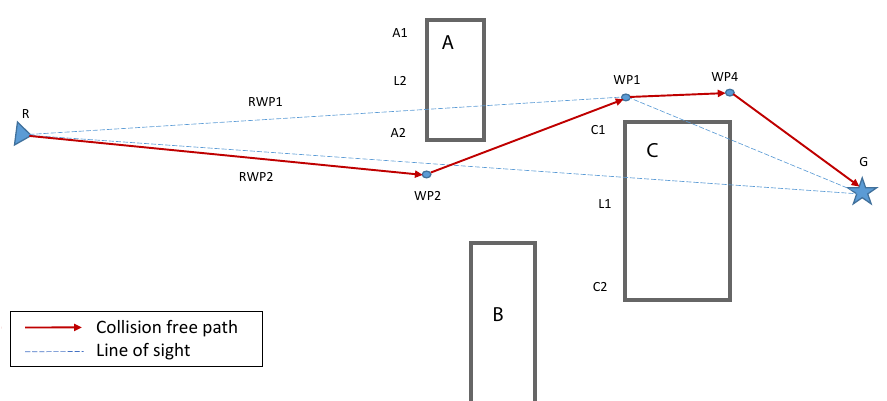
Figure 3. Immediate waypoint